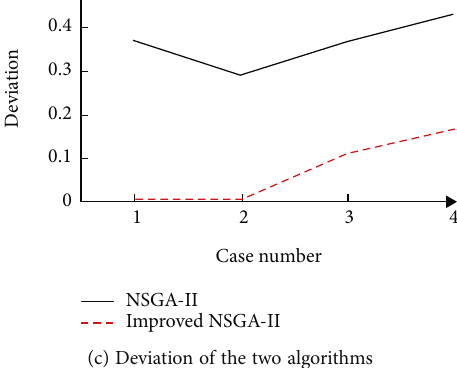
Figure 9: The performance of the algorithm in the actual optimization cases.